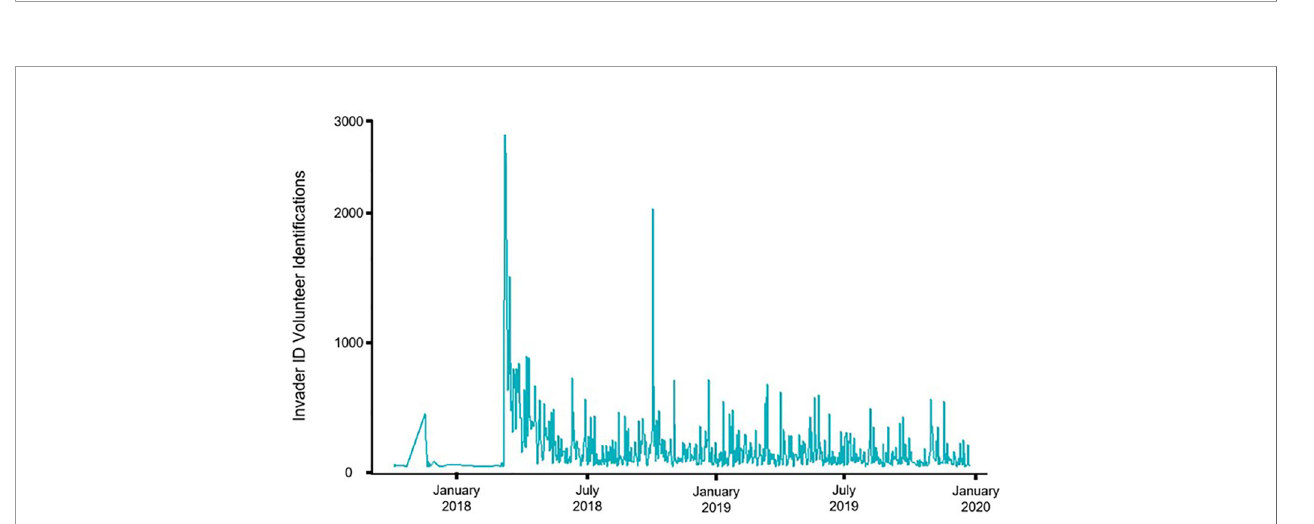
FIGURE 6 | Volunteer identi fi cations over time on Invader ID, the of fi cial public launch occurred in March